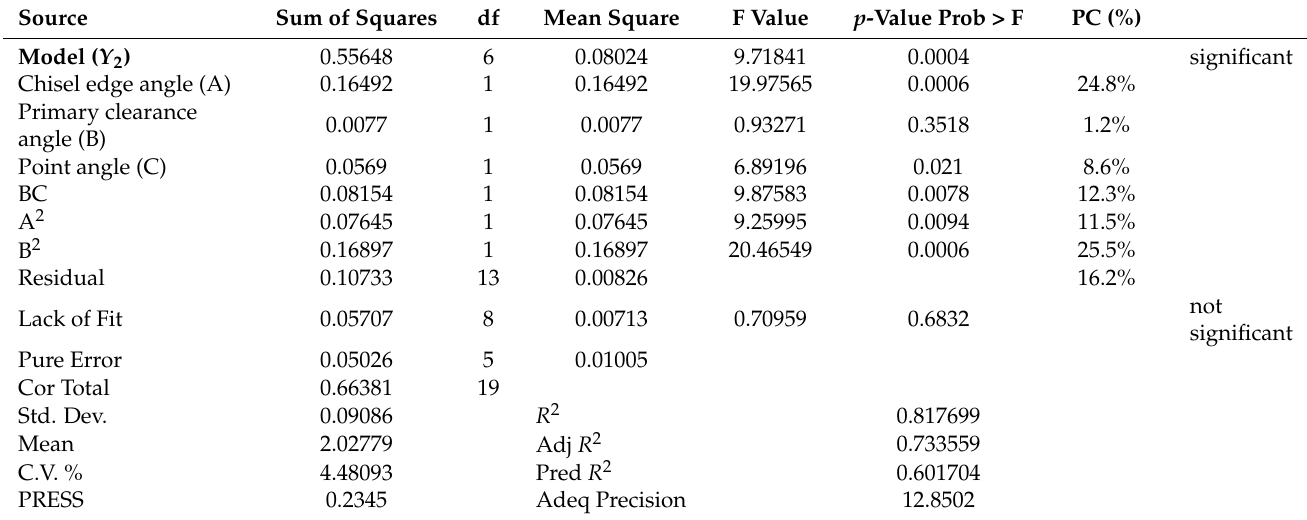
Table 5. Pooled ANOVA of model for maximum burr formation at the exit of Al7075-T6